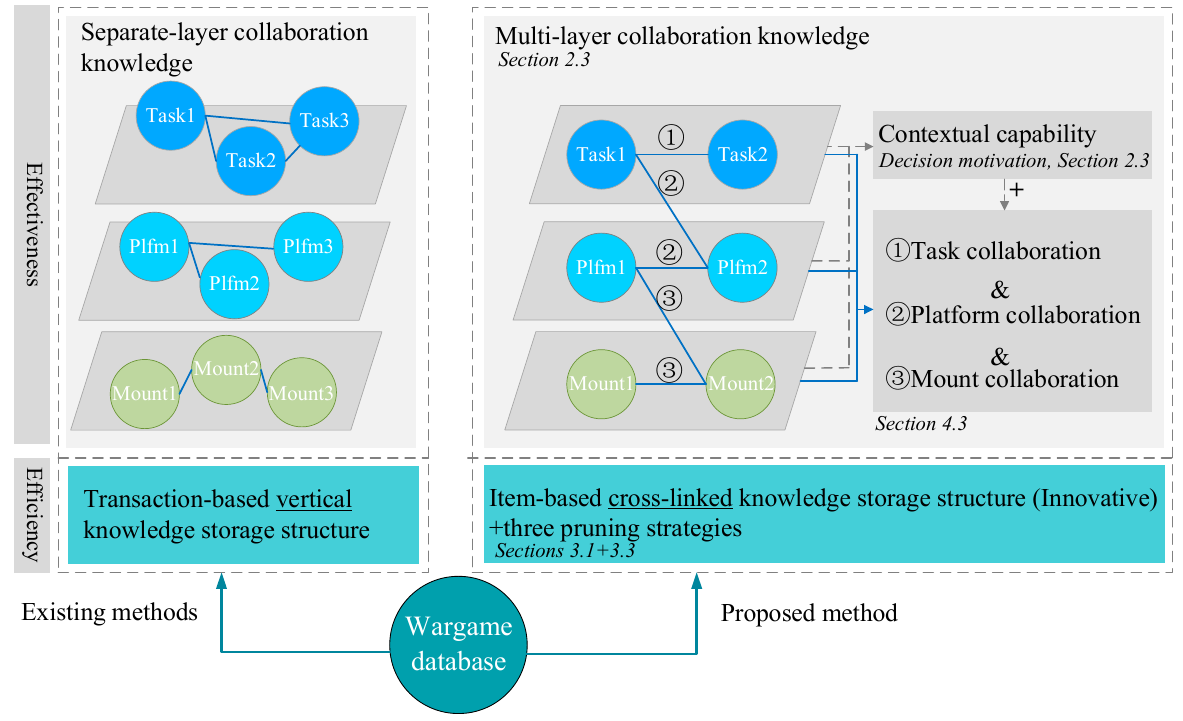
Figure 1. Comparisons between the existing knowledge discovery methods and the proposed method. (Plfm: Platform).